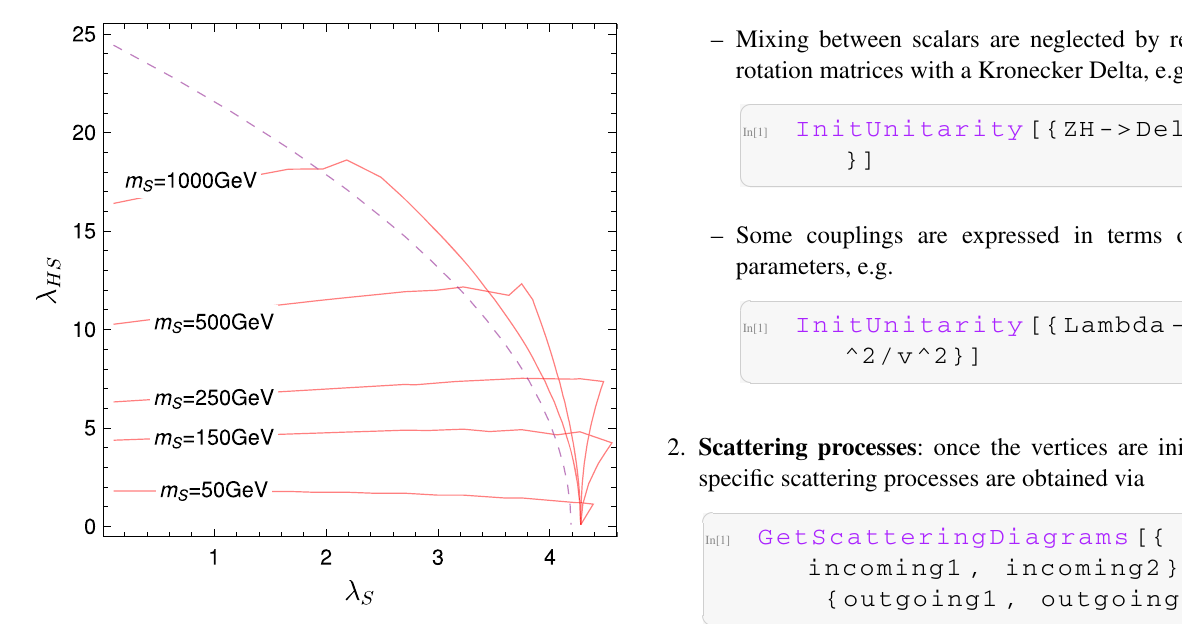
Fig. 3 Unitarity constraints for the singlet extended SM. The dashed purple line gives the limit when using only point interactions in the large s limit. The red lines give the constraints for the full calculation for different singlet masses